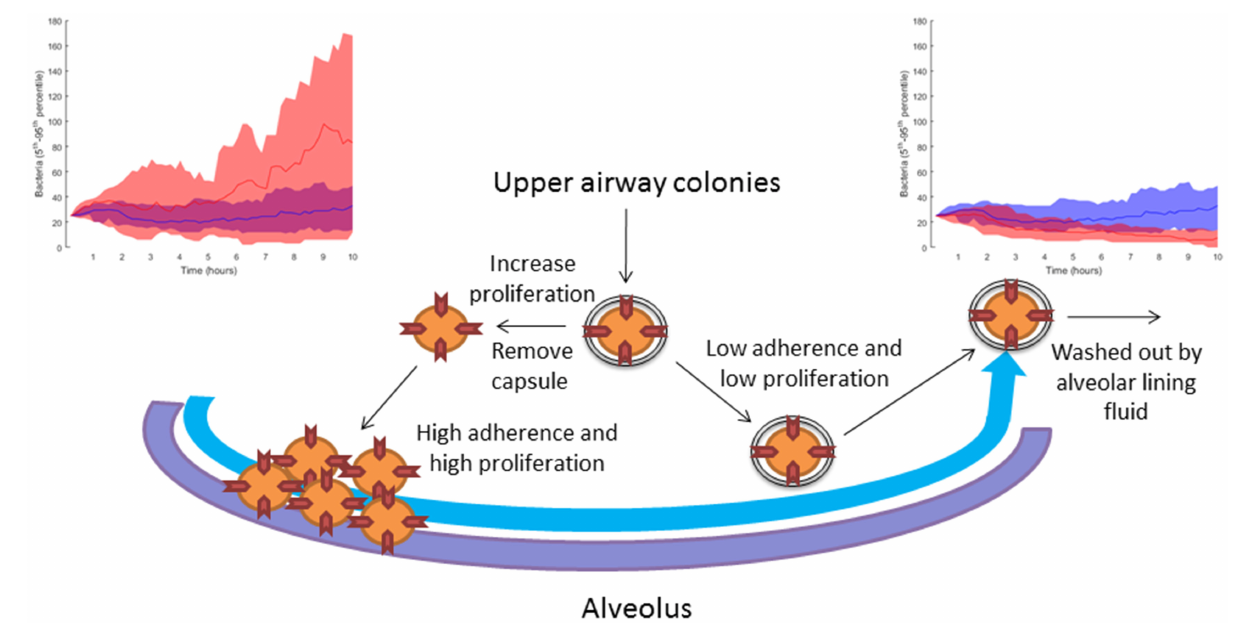
FIGURE 11 | Sketch of the modeling-based predicted strategies pursued by bacteria attempting to infect the alveoli. When the bacteria increase their proliferation rate and decrease their capsule production, they can accumulate in the alveolus due to higher adherence to the epithelial tissue. The top left-hand diagram shows in red 10 simulations with reduced capsule production ( caps = 5h) and increased proliferation ( doub = 100min), compared to 10 simulations of the nominal solution in blue (see section Materials and Methods). If the bacteria keep their initial upper-airway phenotype of low proliferation and capsule production, they are washed out by the lining fluid and do not succeed in infecting the alveolus. The top right-hand diagram shows in red 10 simulations with increased capsule production ( caps = 2h) and reduced proliferation ( doub = 400min) compared to 10 simulations of the nominal solution in blue (see section Materials and Methods).